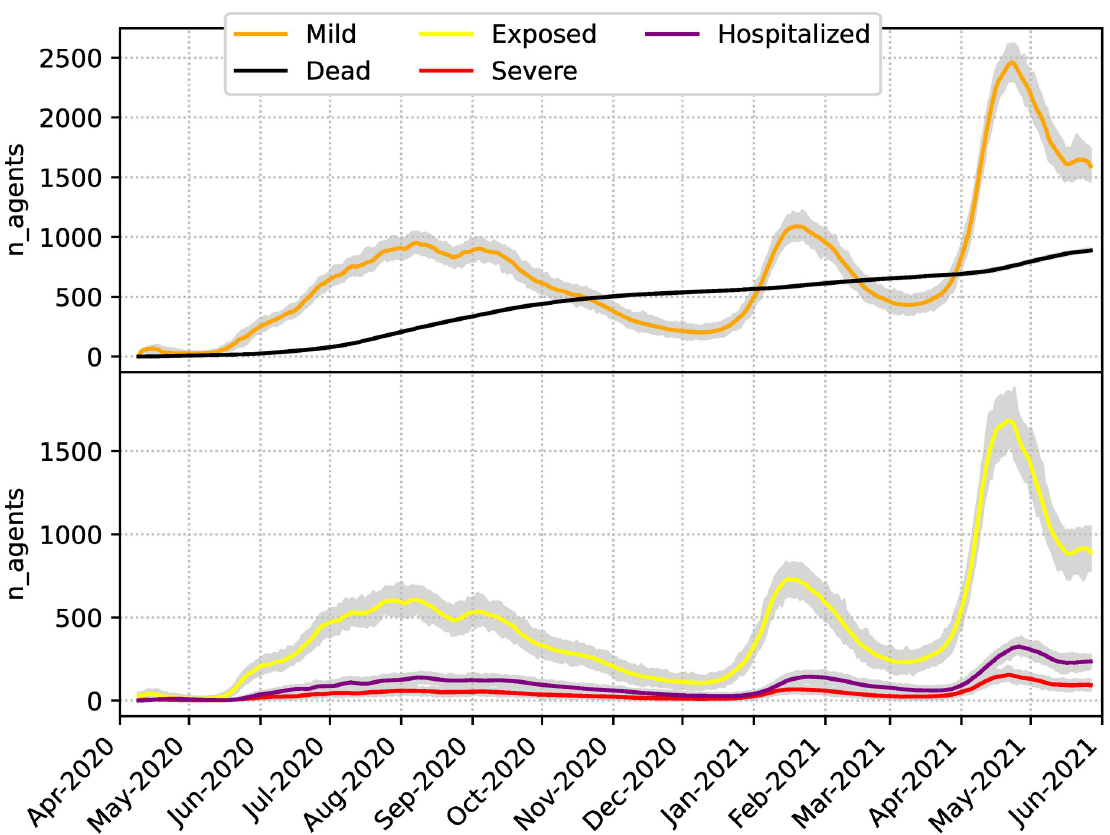
Fig 12. Total number of agents for different epidemiological categories. Grey lines indicate ensemble members and colored solid lines their mean.